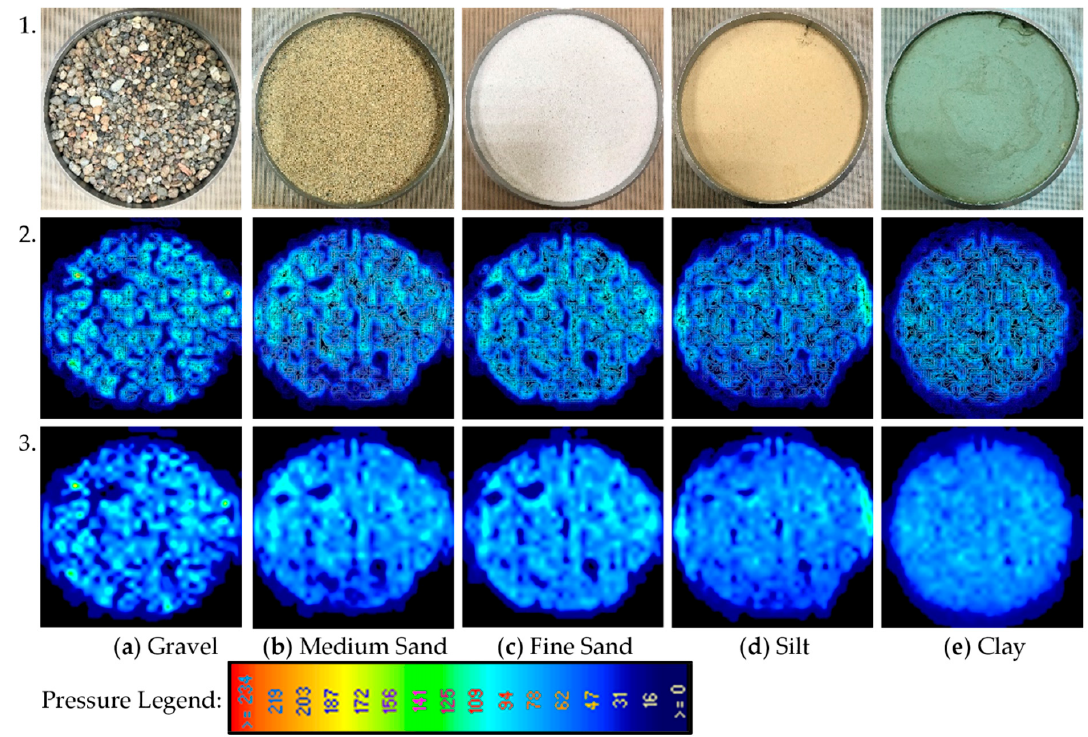
Figure 8. Stress maps were obtained by the tactile sensor for different soils. Row 1. Photo of soil, Row 2 . Contour stress, Row 3. Average stress. ( a ) Gravel; ( b ) Medium Sand; ( c ) Fine Sand; ( d ) Silt; ( e ) Clay.